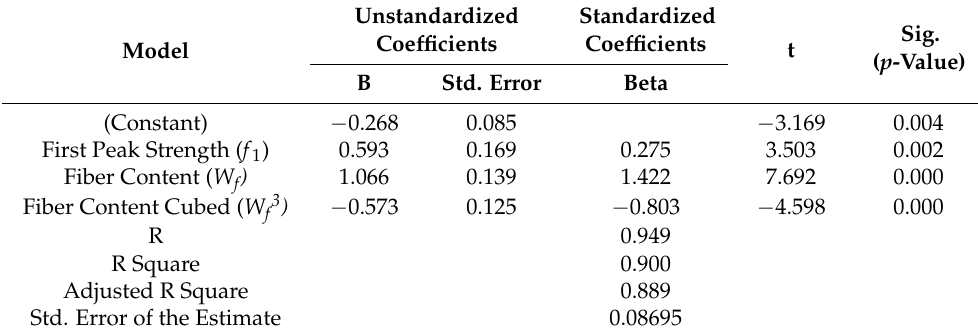
Table 9. Model summary.